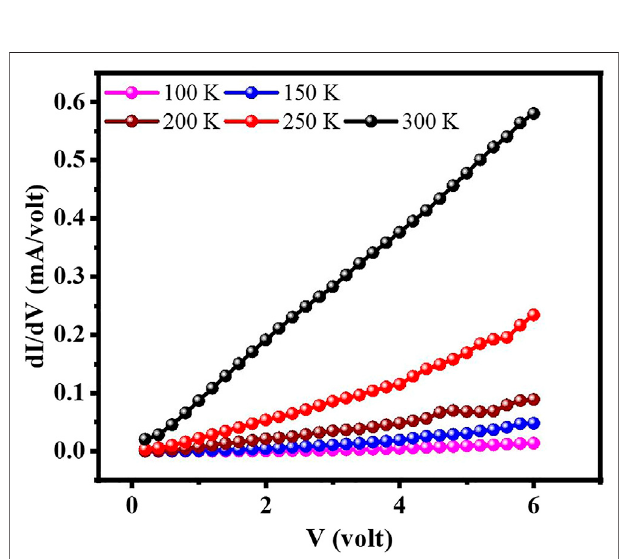
FIGURE 7 | Plot of conductance versus voltage of the NZFO/MgO/p-Si heterostructure recorded in the temperature regime of 100 – 300 K.